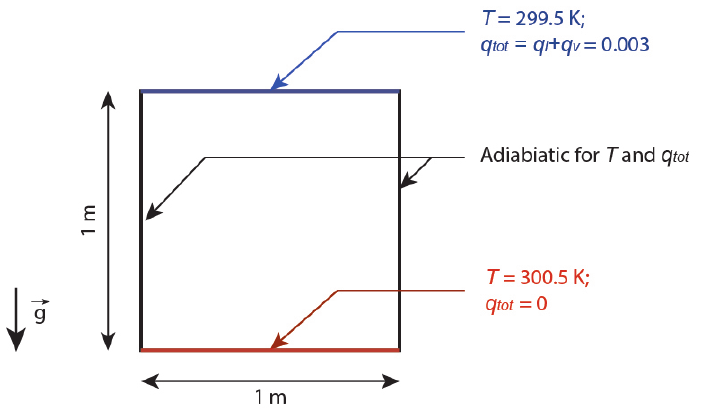
Figure 1. Configuration of the double convective Rayleigh-Bénard.